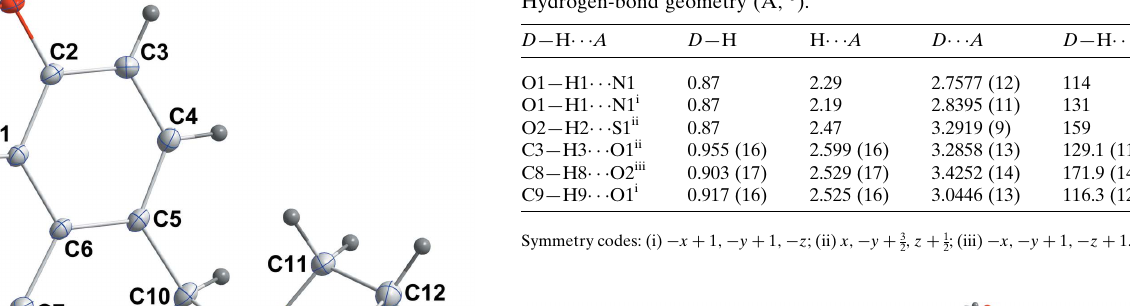
(Table 1 and Figs. 2–4). C9—H9 (cid:2) (cid:2) (cid:2) O1 i hydrogen bonds also occur.